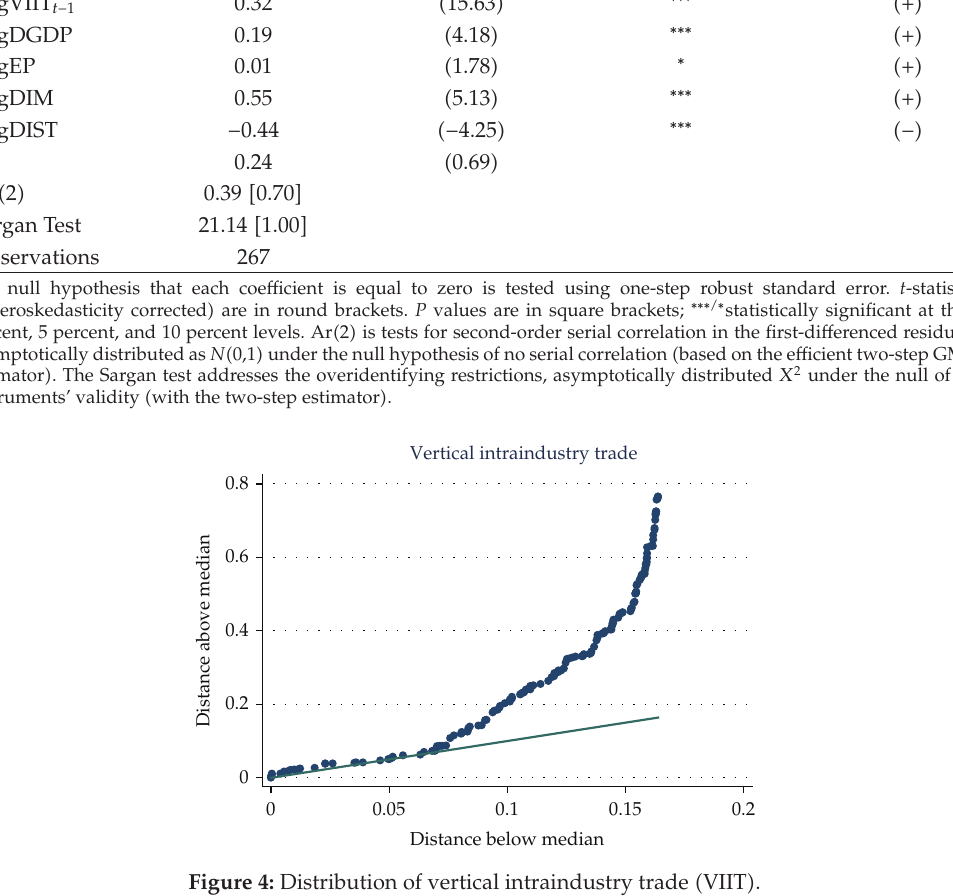
Figure 4: Distribution of vertical intraindustry trade (cid:2) VIIT (cid:3)